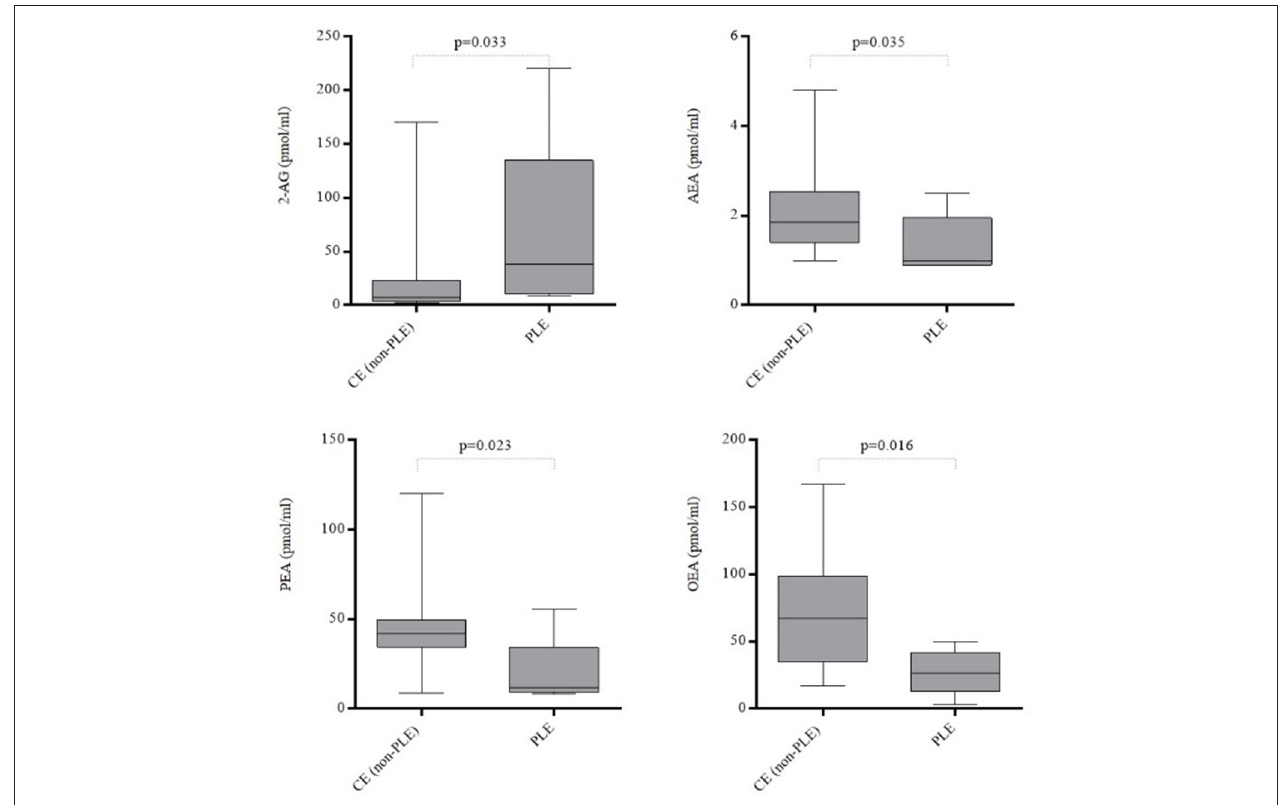
FIGURE 3 | Plasmatic concentrations of 2-arachidonoylglycerol (2-AG), N-arachidonoylethanolamine (AEA), N-palmitoylethanolamine (PEA) and N-oleoylethanolamine (OEA) in dogs affected by chronic enteropathy with ( n = 5) and without ( n = 28) losing of proteins across the gut. CE, Chronic Enteropathy; PLE, Protein-Losing Enteropathy. Boxes show interquartile ranges with median values represented by the central lines, and minimum and maximum values represented by the endpoints of vertical